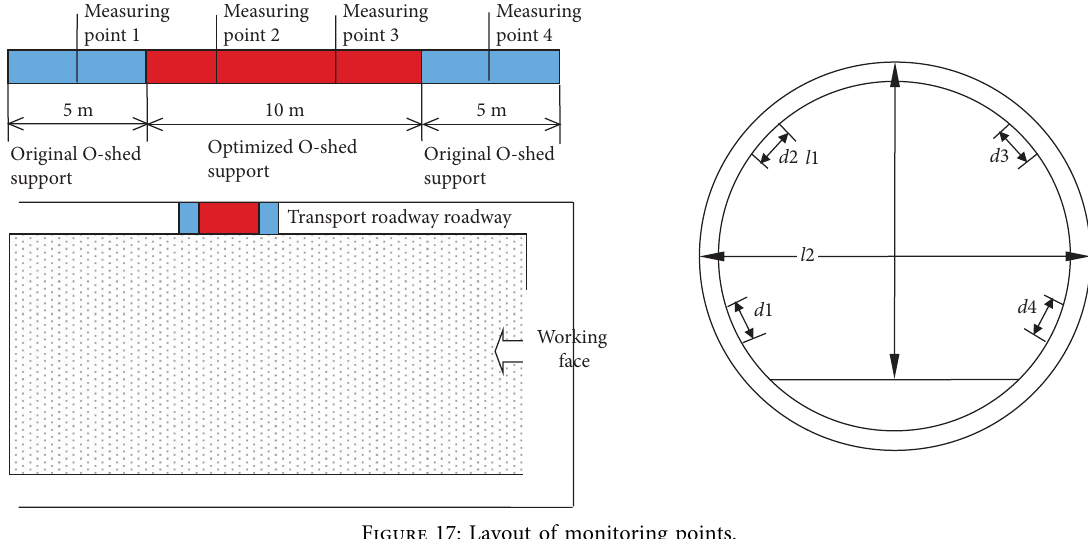
Figure 17: Layout of monitoring points.